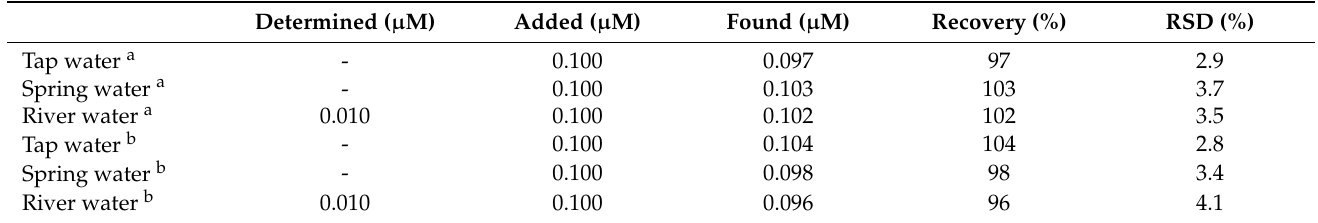
Table 2. Dual-signal LSASV analysis of As(III) in real water samples on Au s /Py/C-MWCNTs/GCE.